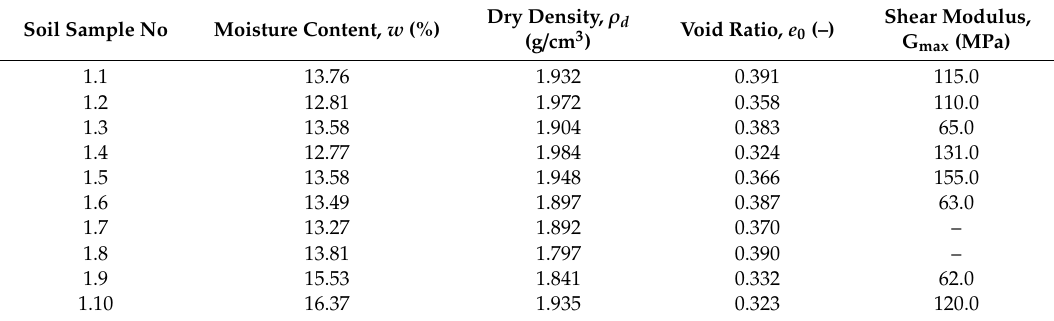
Table 1. Soil index properties for the samples in cyclic triaxial test.